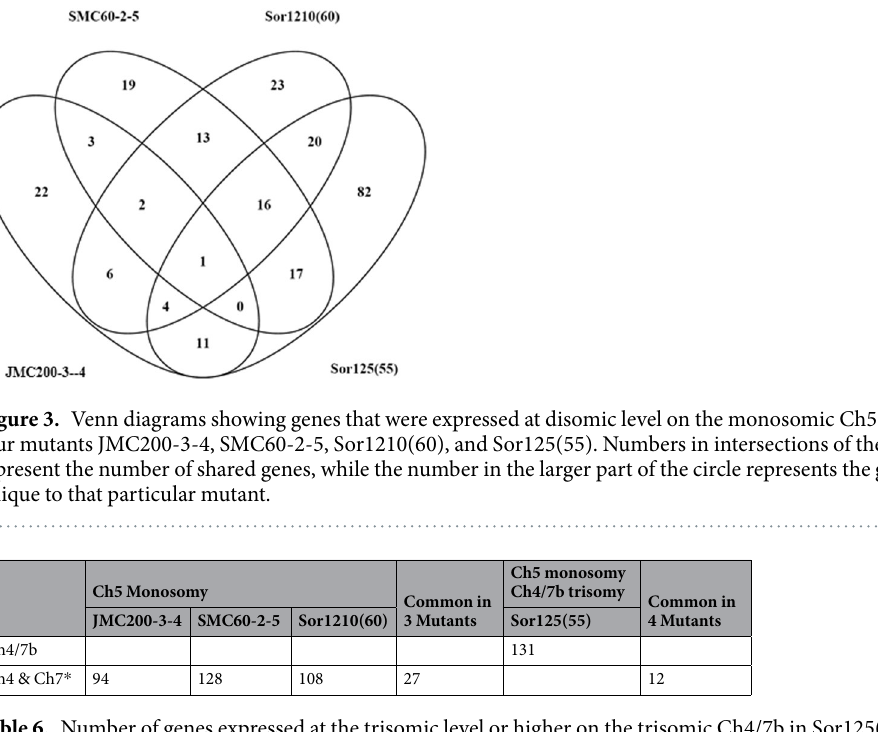
Table 6. Number of genes expressed at the trisomic level or higher on the trisomic Ch4/7b in Sor125(55) and on the disomic Ch4 or Ch7 in JMC200-3-4, SMC60-2-5, and Sor1210(60). * Disomic genes that are expressed at the trisomic level or higher in JMC200-3-4, SMC60-2-5, and Sor1210(60) out of a total of 402 genes residing on the trisomic